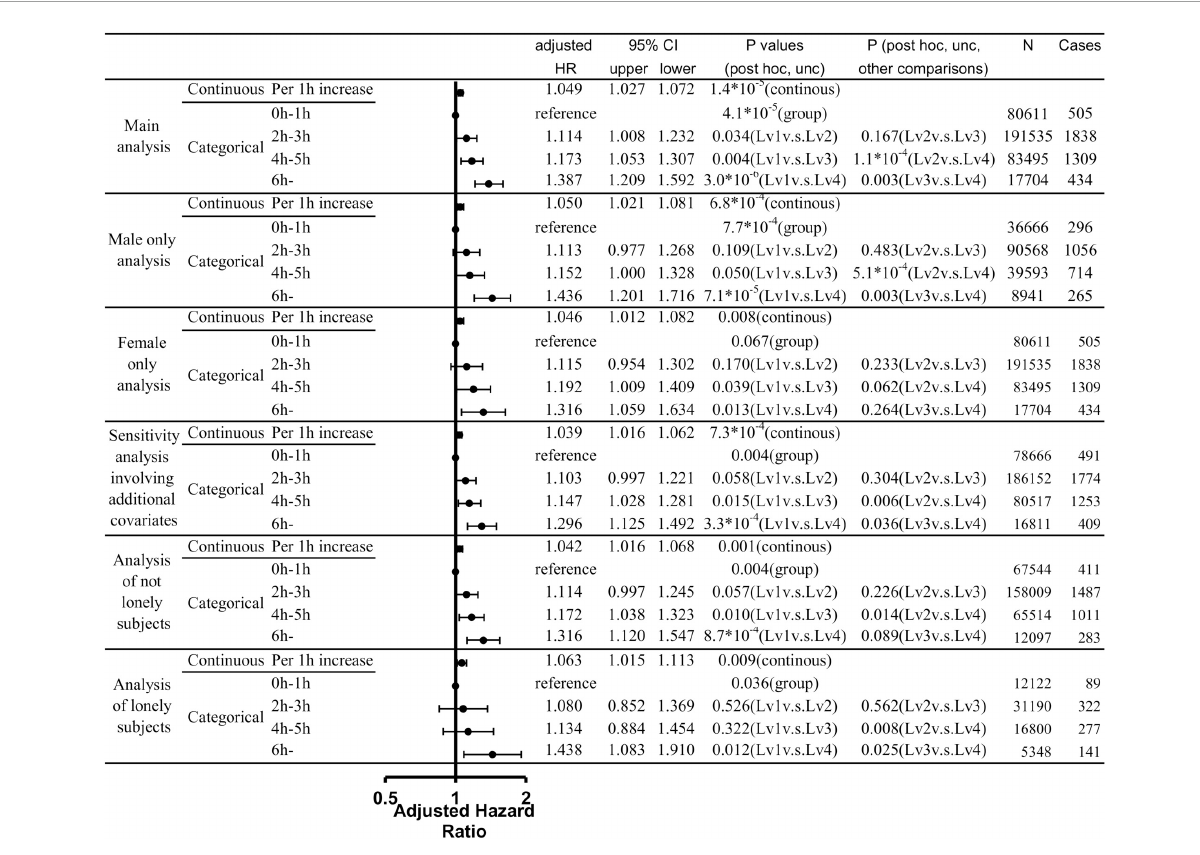
FIGURE2 Statistical values and hazard ratios (HRs) with 95% confidence intervals (95% CIs) for the associations between length of TV viewing and all-cause dementia incidence from the main analyses and sub-analyses. Results of analyses that treated the TV viewing length as the continuous variable and analyses that treated the TV viewing length as the categorical variable were presented. P -values of each analysis, adjusted HR, cases and the participant of each category were